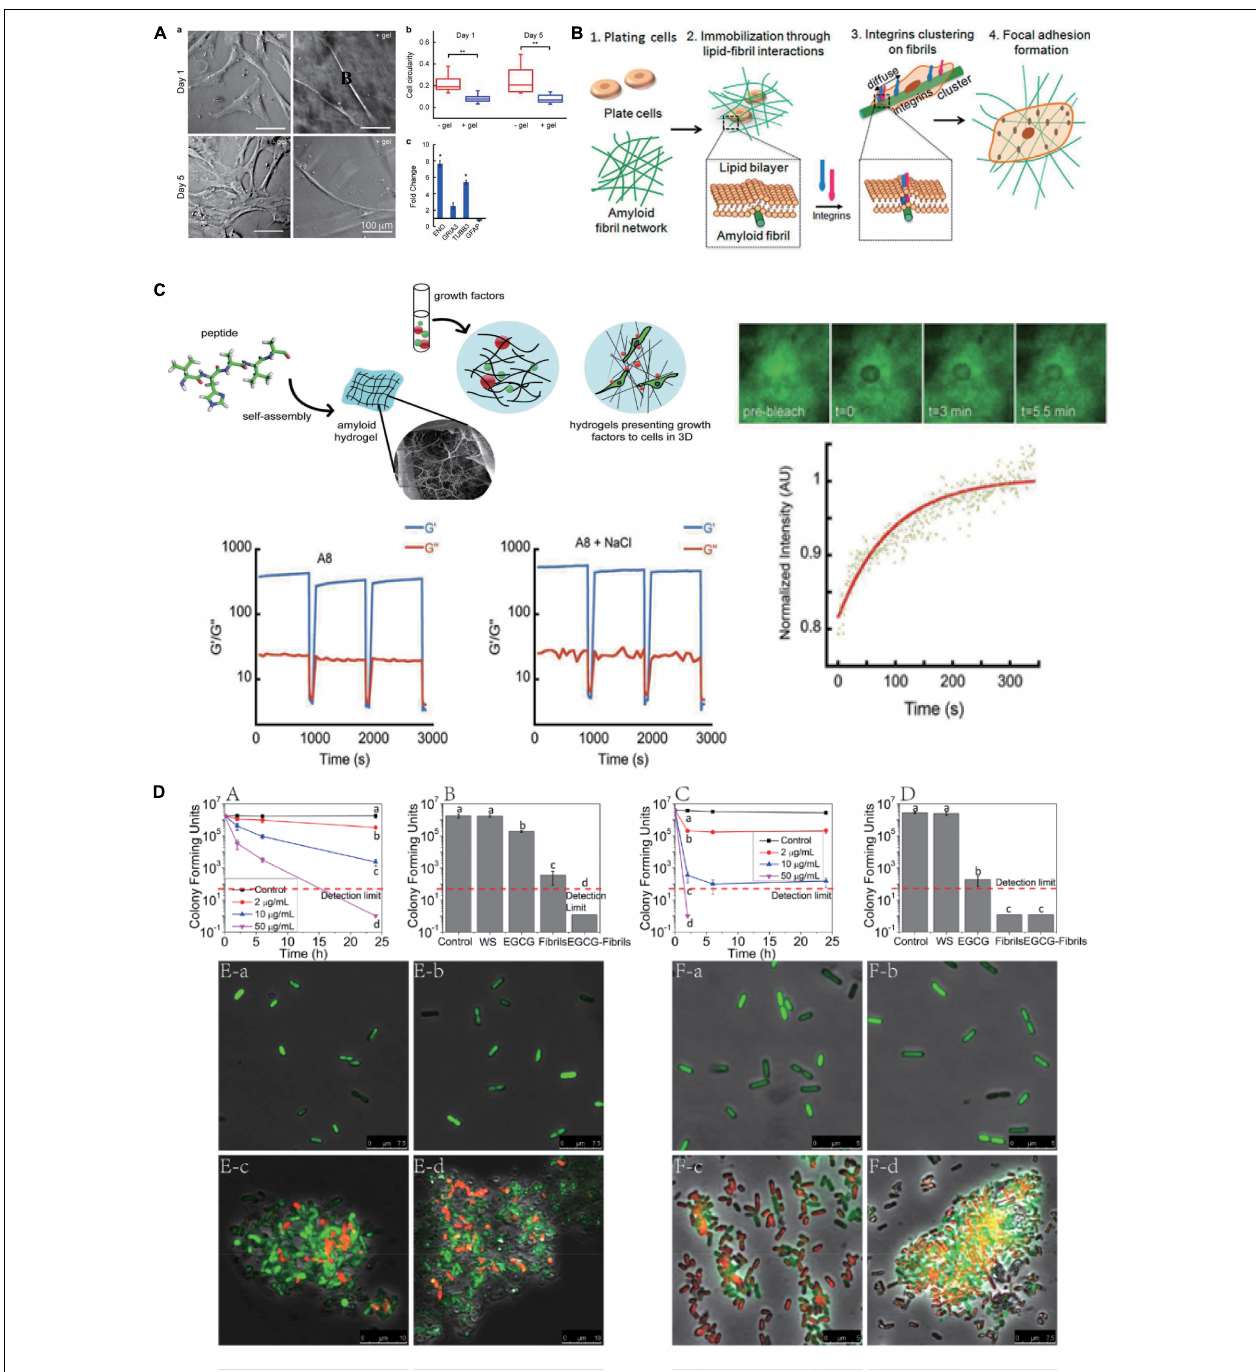
FIGURE 1 | Biomedical applications of amyloidal-inspired hydrogel in previous reports. (A) Differentiation of mesenchymal stem cells with amyloid hydrogels. Morphology, cell circularity, and expression of genes related to neuronal differentiation characterization of hMSCs incubated on Fmoc-VYAVA-based hydrogel and glass matrix. Student’s t -test was performed to evaluate the difference between two groups. Statistical significance was defined as * p < 0.05, ** p < 0.01. (B) Schematic of the mechanism of cell spreading on amyloid fibrils. (C) Schematic of peptide monomer self-assembling to form amyloid hydrogels with distinct pore structures, which can encapsulate growth factors for sustained release for stem cells differentiation. Step-strain oscillatory rheology proved that the Fmoc-VHAVA-based hydrogel network was disrupted under high strain (100%) and then recovered under low strain (0.05%) for three cycles. Adapted with permission from Das et al. (2017) (Copyright© 2017 Wiley-VCH Verlag GmbH & Co. KGaA, Weinheim). (D) Antibacterial activity by the agglomeration effect of the polyphenol-binding lysozyme amyloid fibrils (hydrogels). Colony-forming unit counting and confocal laser scanning microscopy (CLSM) results reveal that polyphenol-binding lysozyme amyloid fibrils (hydrogels) show superior antibacterial capacity on both E. coli and Listeria monocytogenes . Adapted with permission from Hu et al. (2018) (Copyright© 2018, American Chemical Society). Significant differences among different treatments on reducing CFUs determined with one-way ANOVA followed by Tukey’s test, p ≤ 0.05, are indicated by different lowercase letters in A–D.